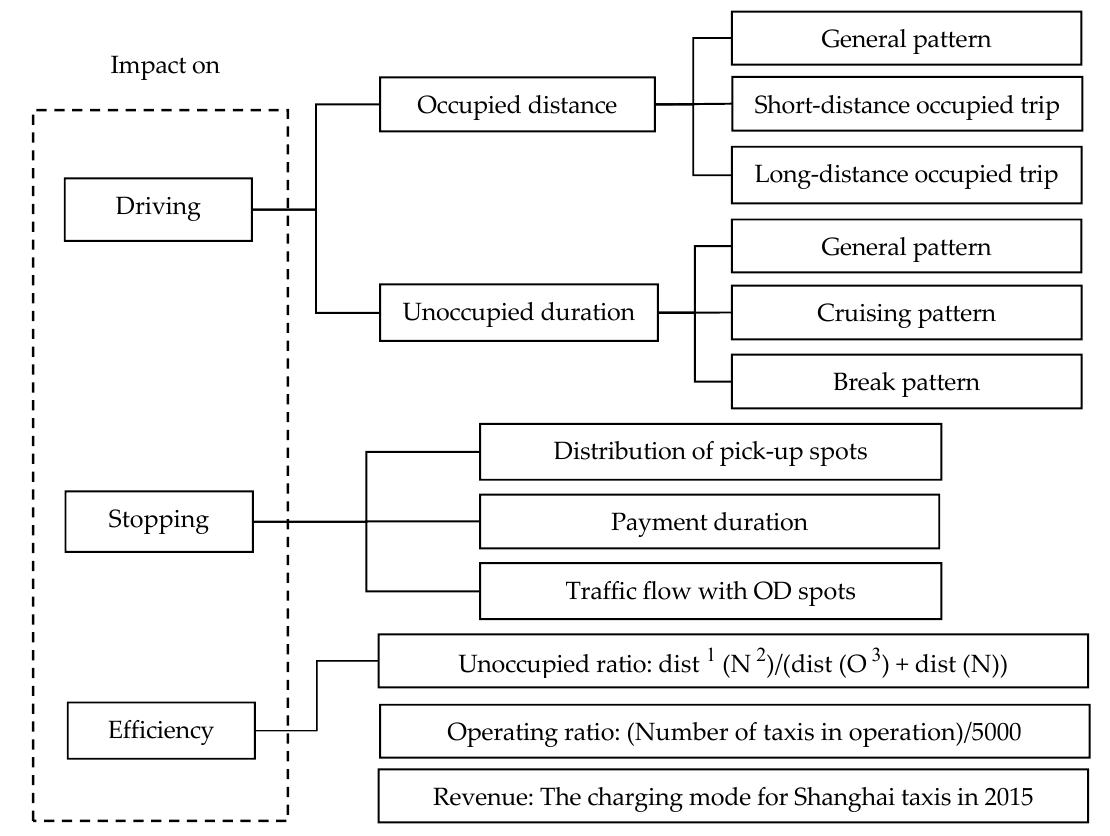
Figure 1. The impact of e-hailing apps on taxi drivers. 1 dist is the distance of the trip, 2 N is the unoccupied trip, 3 O is the occupied trip.